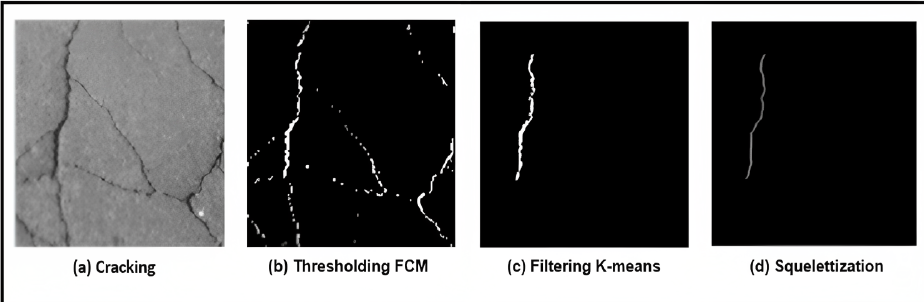
Figure 19. Example of false classification of cracking